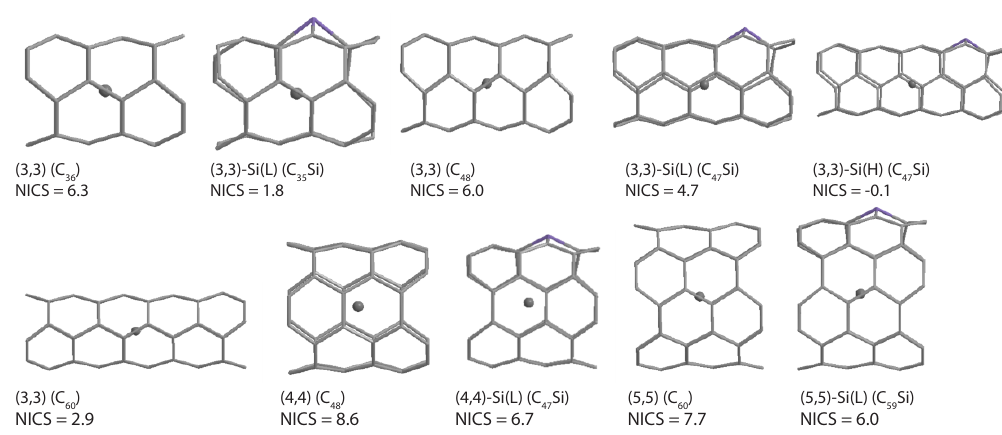
Figure 2. The NICS values at the tube center of the SWCNTs at B3LYP/6-31G(d) level